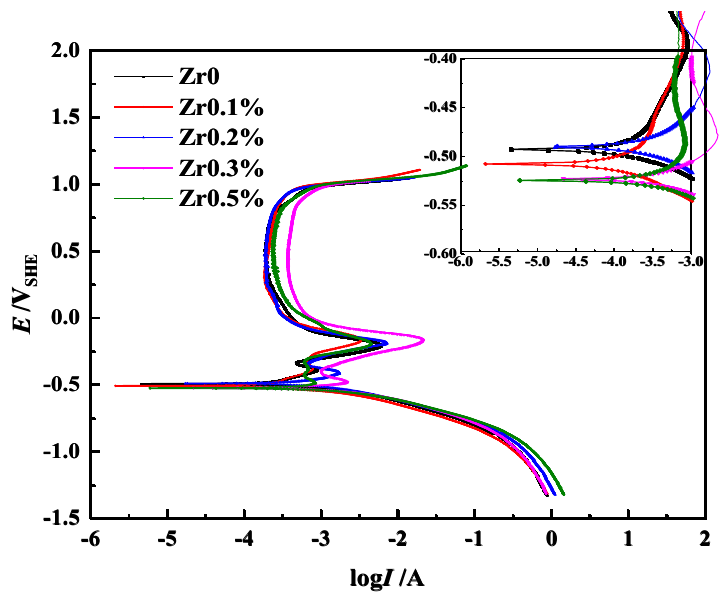
Figure 5. Potentiodynamic polarization curves of AlCoCrFeNiZr x (x = 0, 0.1, 0.2, 0.3, and 0.5) alloys in a 0.5 M H2SO4 solution. Table 4. Potentials and current densities of AlCoCrFeNiZr x ( x = 0, 0.1, 0.2, 0.3, and 0.5) alloys in a 0.5 M H 2 SO 4 solution. Alloy